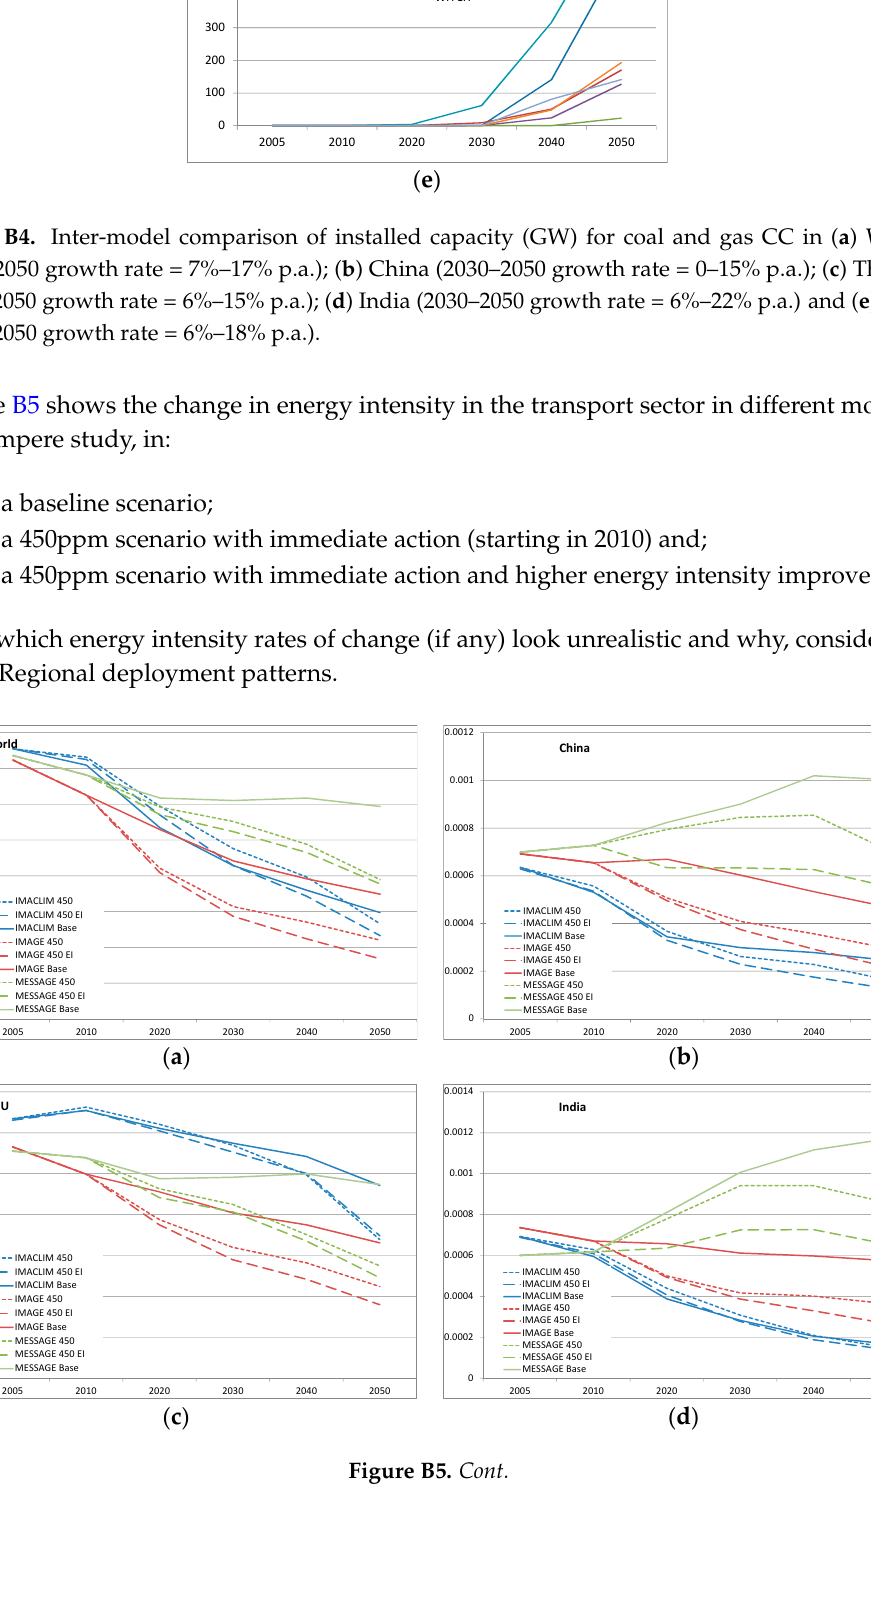
( e ) Figure B5. Inter-model comparison of the change in energy intensity in the transport sector in ( a ) World (Annual rate of energy intensity improvement: 2005–2010 = 2%, 2010–2050 = 1% to 3%); ( b ) China (Annual rate of energy intensity improvement: 2005–2010 = 1%, 2010–2050 = − 1%–4%); ( c ) The EU (Annual rate of energy intensity improvement: 2005–2010 = 1%, 2010–2050 = − 2%–4%); ( d ) India (Annual rate of energy intensity improvement: 2005–2010 = 1%, 2010–2050 = 0.3%–2.5%) and ( e ) USA (Annual rate of energy intensity improvement: 2005–2010 = 2%, 2010–2050 = 1%–3%). Appendix C. Logistic Growth Appendix C.1. The Generalised S-Shaped Growth Model This is a summary of the approach outlined by Wilson et al. [23] in their study. The curve used to describe the growth of technologies is a three parameter logistic function as follows: (cid:1877) = (cid:1837) (cid:4666)1 + (cid:1857) (cid:2879)(cid:3029)(cid:4666)(cid:3047)(cid:2879)(cid:3047) (cid:3116) (cid:4667) (cid:4667) and ∆(cid:1872) = (cid:2869) (cid:3029) log 81 where (cid:1837) is the asymptote indicating the saturation level, (cid:1854) is the diffusion rate or steepness of the curve, ∆(cid:1872) is the time period over which (cid:1877) grows from 10% to 90% of (cid:1837) , and (cid:1872) (cid:2868) is the inflection point at the point of maximum growth i.e., at (cid:1837) 2⁄ . As highlighted by Wilson et al. [23], this is a recognised approach which is well-documented in the literature. The data of cumulative installed capacity of technologies from the model runs were fitted to this logistic function using a least sum of the squares fit in order to determine the values of the constants. In order to control for the fact that the size of the energy system may vary during the period over which the technology is diffused and that a larger energy system results in larger absolute value of (cid:1837) , normalised values of (cid:1837) were calculated. The primary energy consumption values taken at the inflection point of the logistic function were used as the normalising factor. Note that normalised (cid:1837) has units of MW/EJ and is therefore not meaningful in absolute terms. Appendix C.2. Multiple Logistic Substitution